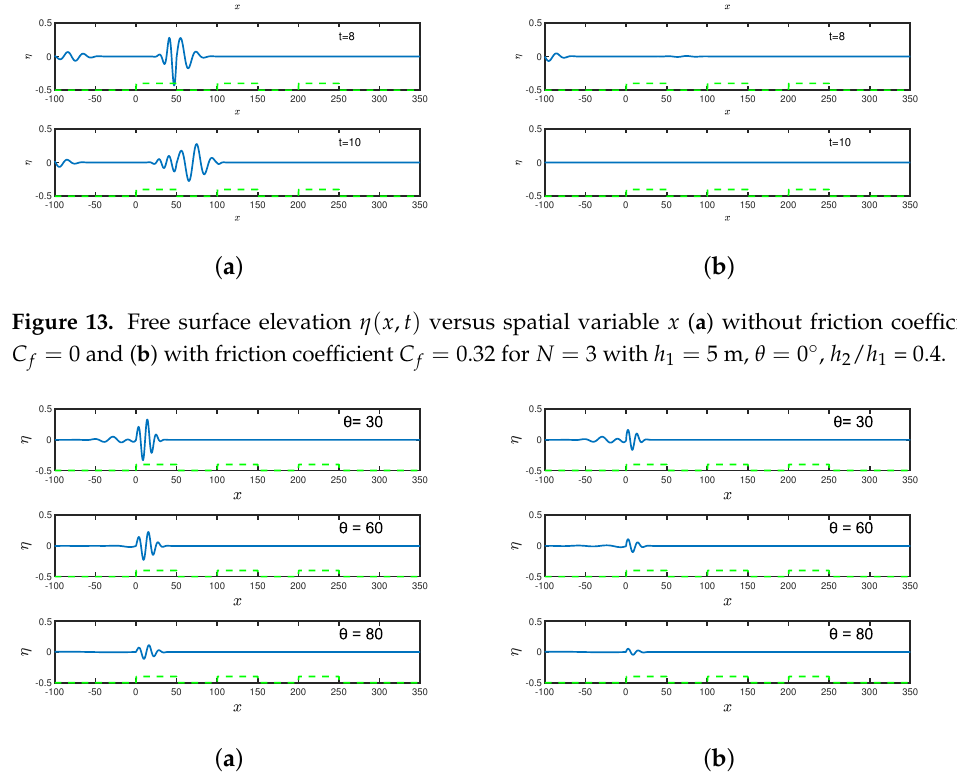
Figure 14. Free surface elevation η ( x , t ) versus x for different angle θ ( a ) with friction coefficient C f = 0.0 and ( b ) with friction coefficient C f = 0.32 for N = 3, t = 2 s.